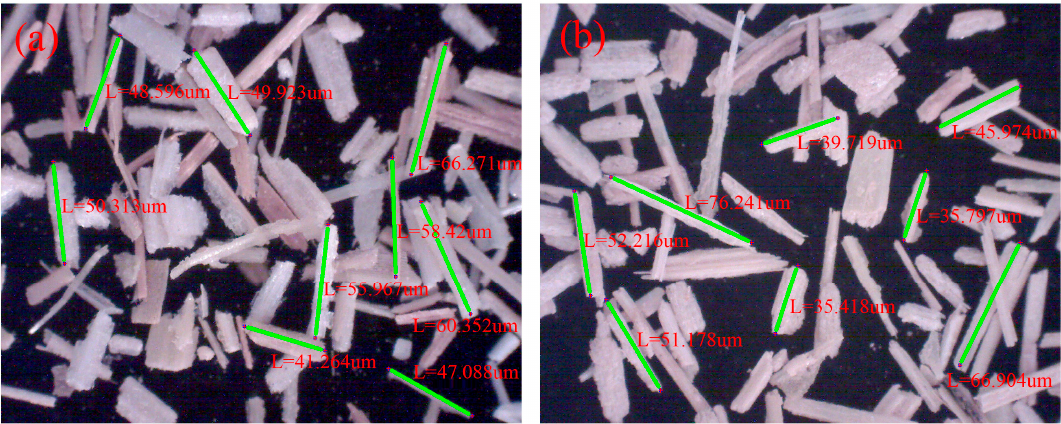
Figure 1. Optical microscope images of ( a ) untreated wheat straw fiber and ( b ) wheat straw fiber treated by A171 and modified TiO 2 nanoparticles.